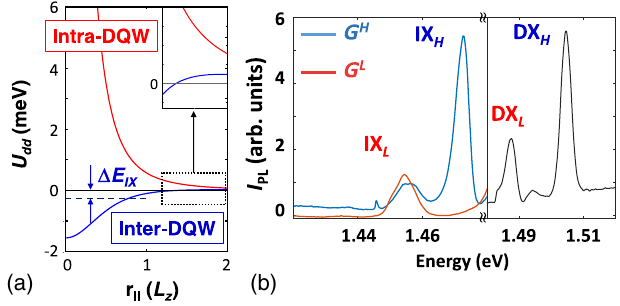
FIG. 2. Interaction potential between indirect excitons (IXs) andand their excitation spectra (a) intra- (red curve) and inter- DQW (blue curve) dipolar interaction energy U dd ð r Þ , for a pair of IXs as a function of the lateral IX-IX separation r calculated jj from Eq. (1) for the DQW stack used in the studies. While the intra-DQW interaction is always repulsive, the inter-DQW one ffiffiffi p < 3 L becomes attractive for r z and forms an IX-IX bound jj [44]. Here, L z is state with the indicated binding energy j Δ E IX j the vertical separation between the DQWs. (b) Photolumines- cence (PL) spectra of the indirect (left) and direct (right) exciton transitions. The IX transitions on the left are recorded under resonant excitation of their corresponding direct exciton tran- sitions (right) using laser beams G L and G H , respectively.